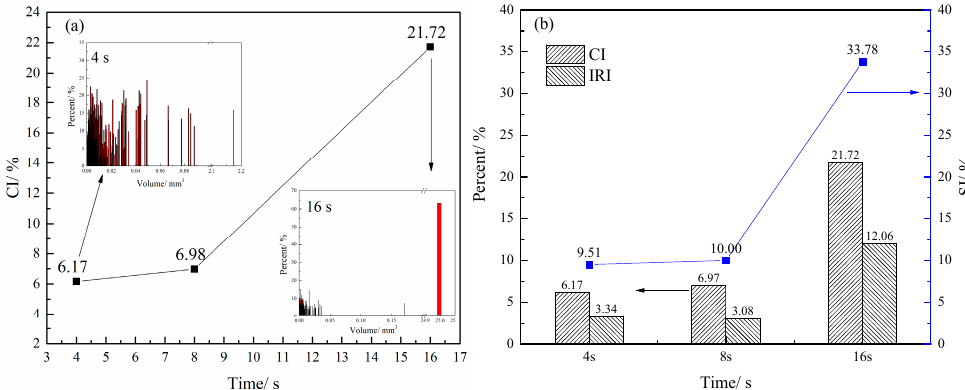
Figure 14. Characteristics Index of #2 iron ore at different times of smelting reduction. ( a ) CI re- sults; ( b )CI and IRI results. ( b ) CI and IRI results.